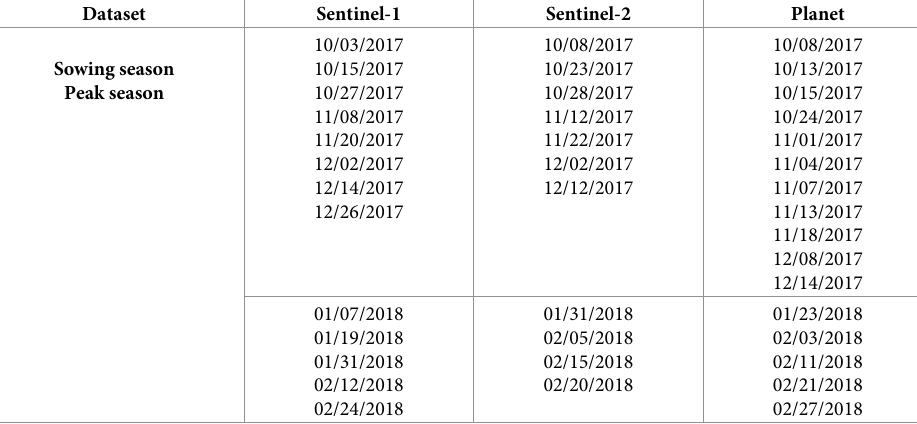
Table 1. List of acquisition dates of satellite images used in our study.